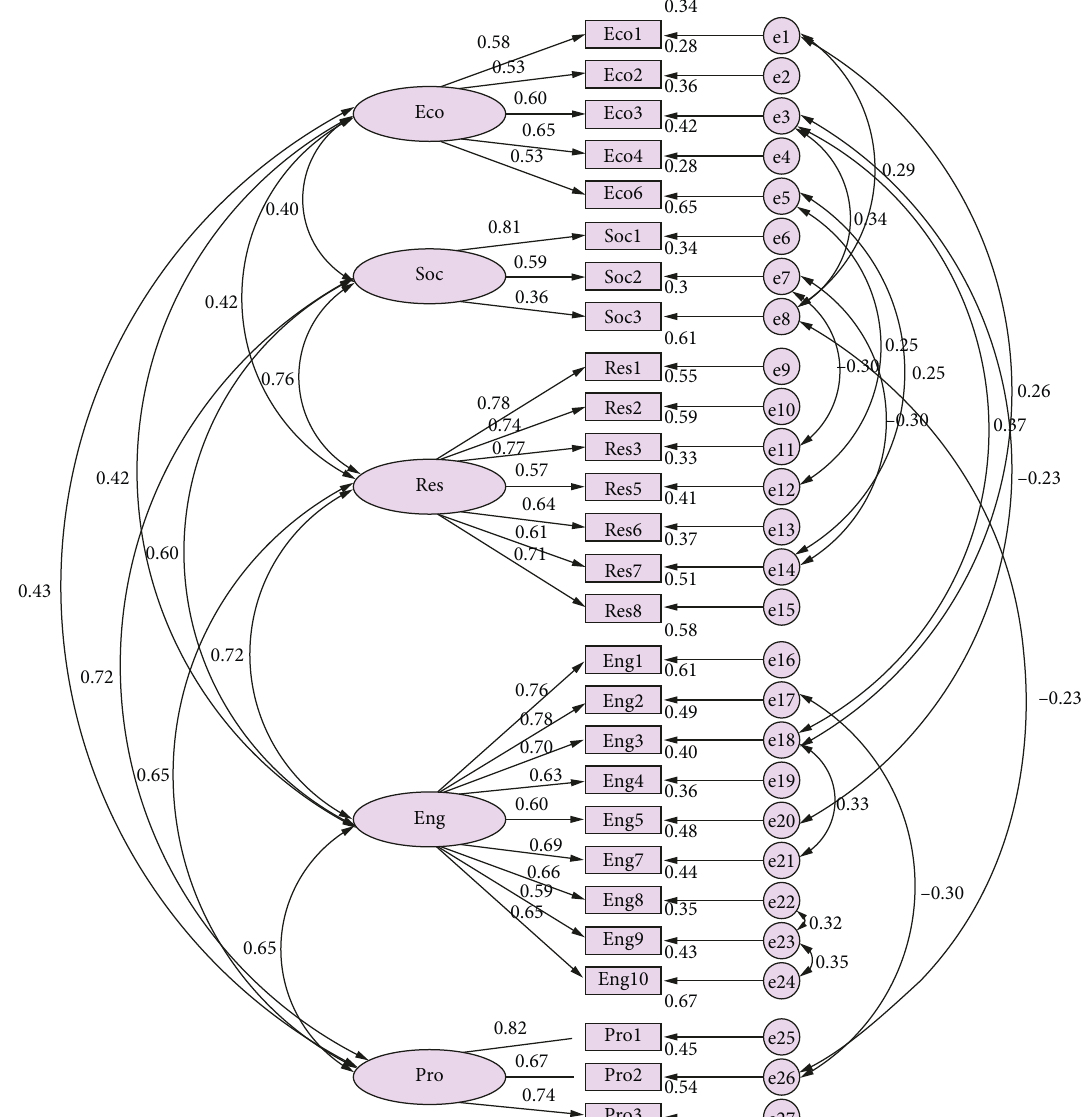
Figure 3: The modified measurement model with standardized path coefficients and factor